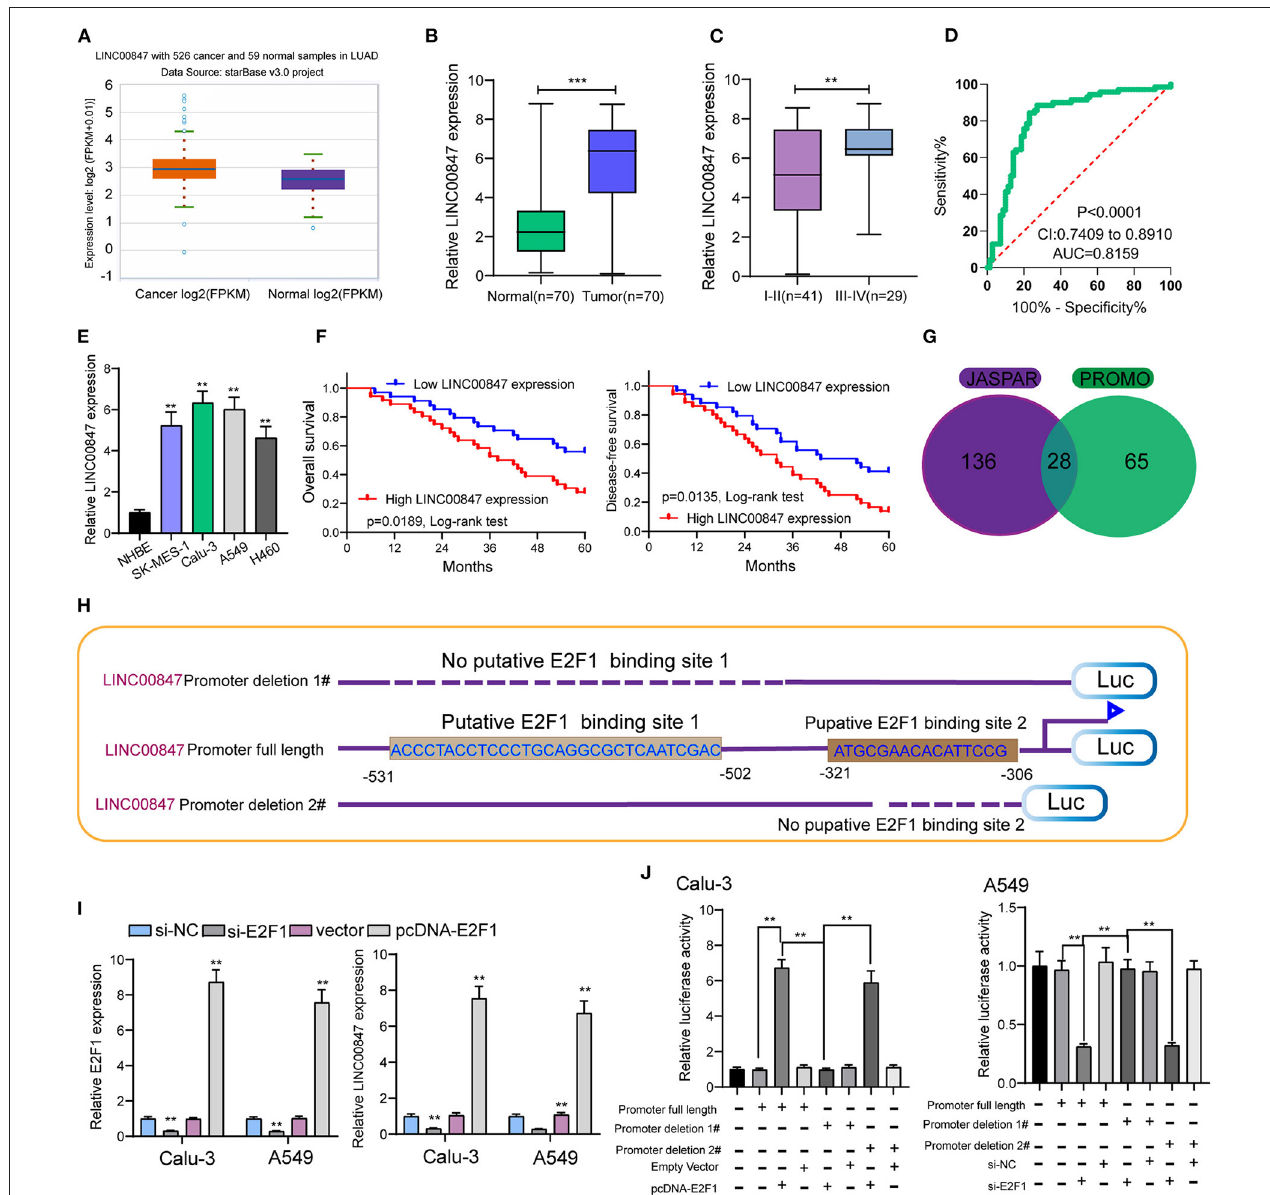
FIGURE 1 | LINC00847 expression was up regulated in NSCLC and induced by E2F1. (A) The expressing trend of LINC00847 in lung cancer and normal lung samples of TCGA datasets. (B) Relative expressions of LINC00847 in 70 NSCLC tissue samples and their paired non-cancerous specimen samples measured by RT-qPCR. (C) LINC00847 expression was higher in advanced NSCLC specimens. (D) ROC assays for the exploration of the diagnostic value of LINC00847 expression in NSCLC specimens. (E) RT-PCR for the determination of LINC00847 levels in four NSCLC cell lines and NHBE. (F) Kaplan-Meier curves for the overall survival and disease-free survival in patients with NSCLC. (G) 28 transcription factors were predicted for LINC00847 using JASPAR and PROMO databases. (H) Description of E2F1-binding sites in the promoter region of LINC00847 and the schematic of LINC00847 promoter deletion 1# and LINC00847 promoter deletion 2# luciferase reporter vectors. (I) The expression of LINC00847 after knockdown or overexpression of E2F1. (J) Relative luciferase activities as analyzed in Calu-3 and A549 cells co-transfected with the related vectors. ** p < 0.01.